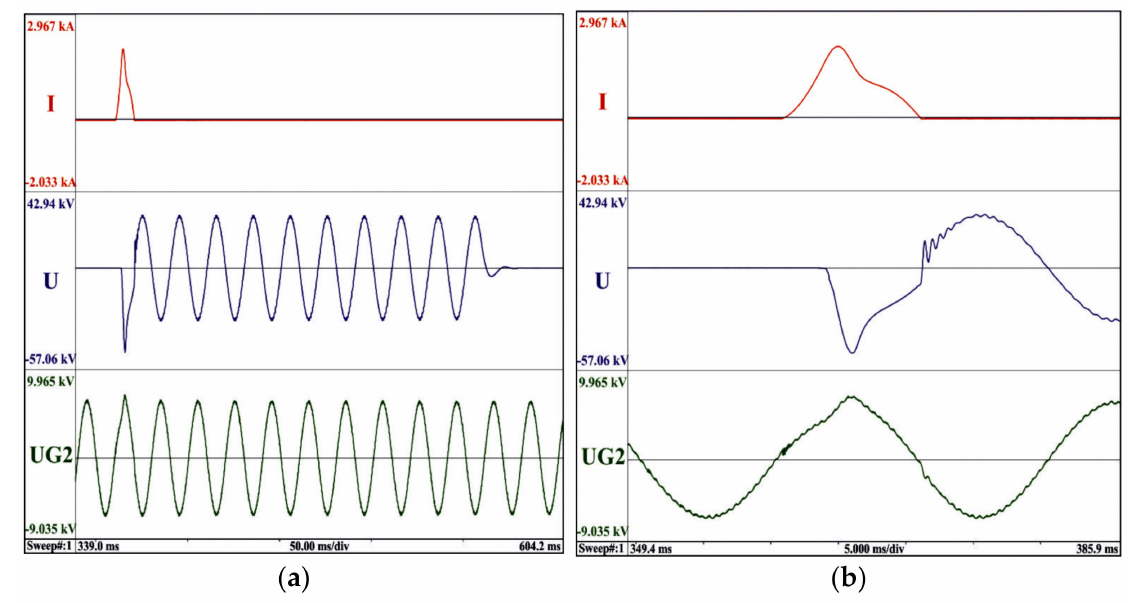
Figure 12. ( a ) Oscillogram obtained for the making angle of short-circuit current of 9.5 electrical degrees; ( b ) connection detail in the oscillogram.